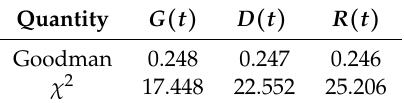
Table 3. The χ 2 fit for the overall voting record G(t) , Democrats D(t) , and Republicans R(t) . This demonstrates the degree of the triangle dichotomy for each pre-defined classification.